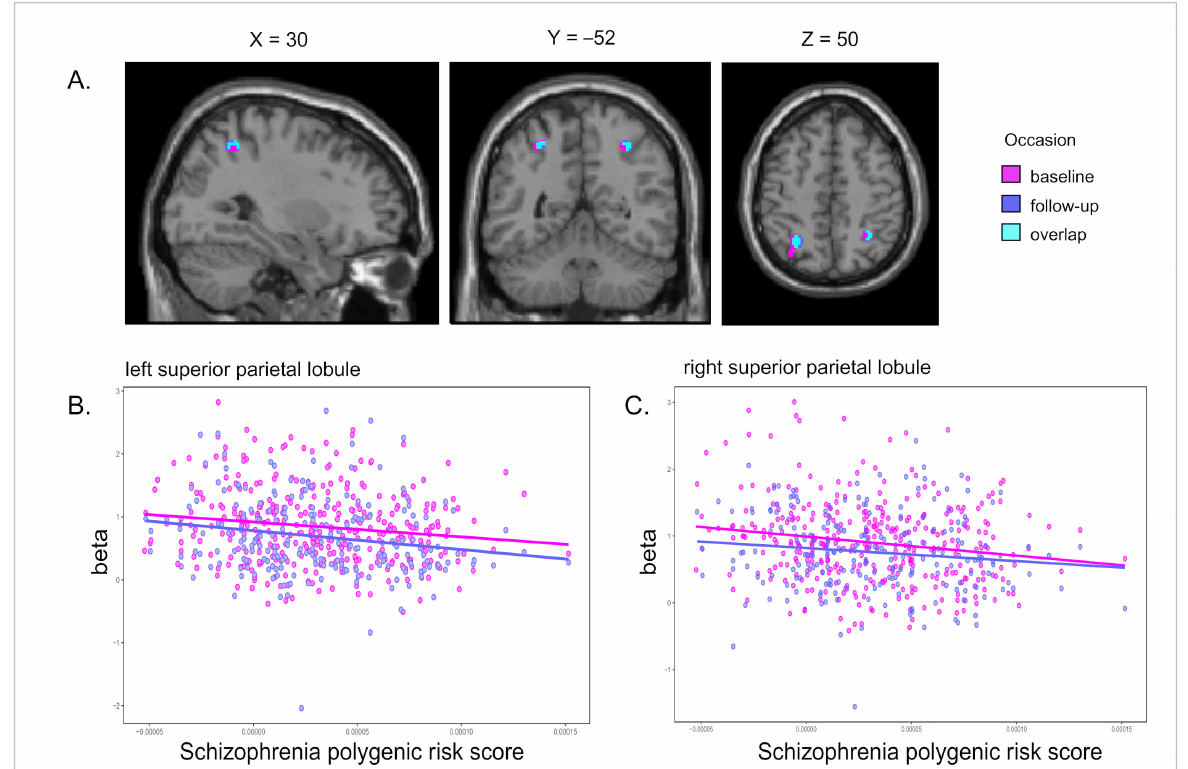
Figure 1. Association between schizophrenia PRS and altered brain activity during episodic memory retrieval at baseline and 4-year follow-up. ( A ) PRS associated with hypoactivation in the bilateral superior parietal lobule during episodic memory retrieval at baseline (voxel threshold: 10, p -value threshold: 0.001 uncorrected), with overlapping activation at follow-up (voxel threshold: 10, p -value threshold: 0.05 uncorrected in regions-of-interest). ( B , C ) Corresponding scatterplot based on peak activity associated with PRS in the left ( B ) and right ( C ) superior parietal